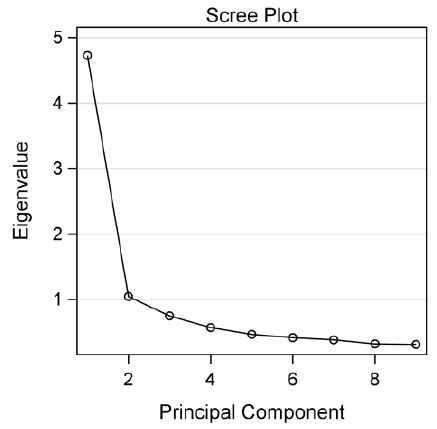
Figure 1. Scree plot based on the principal component analysis ( n = 710).